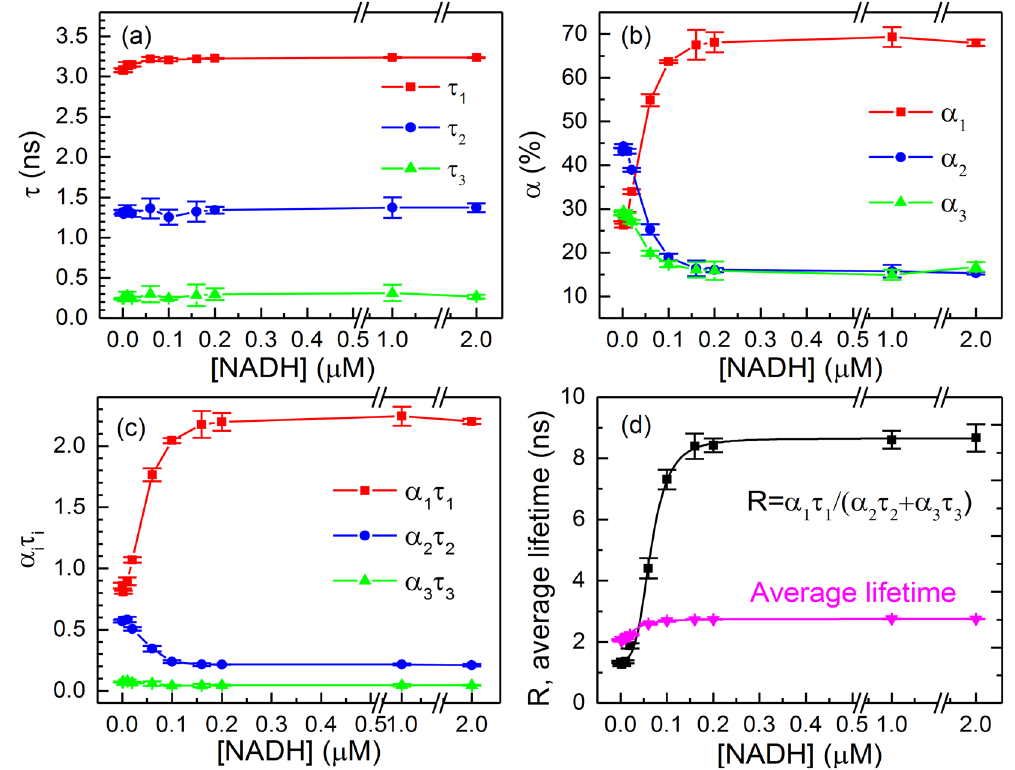
Figure 2. Time-resolved fluorescence of of Peredox in the NADH concentration titration experiment. Lifetime τ α i ( a ) and fractional amplitude i ( b ) of Peredox in the NADH concentration titration experiment. The were obtained from the fluorescence decay curves demonstrated in Supplementary Figure S2a. ( c ) Fractional intensities ( α i τ i ) versus NADH concentrations. ( d ) Ratio of fractional intensities ( α τ α τ α τ = + R /( ) average lifetime versus NADH concentrations. The ratio of fractional intensities and average lifetime curves were fitted with Hill equation, and the parameters are presented in Supplementary Table S1. Error bars represent the standard deviation of the